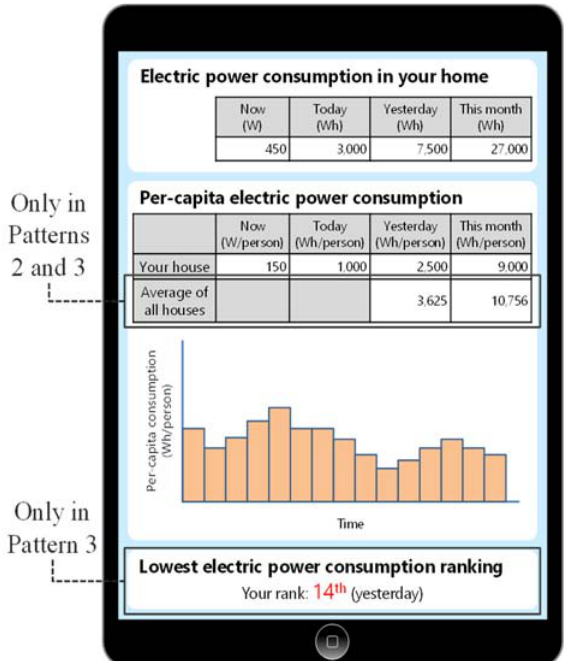
Figure 4. A tablet PC providing real ‐ time feedback. Source: Thoa et al. [5].